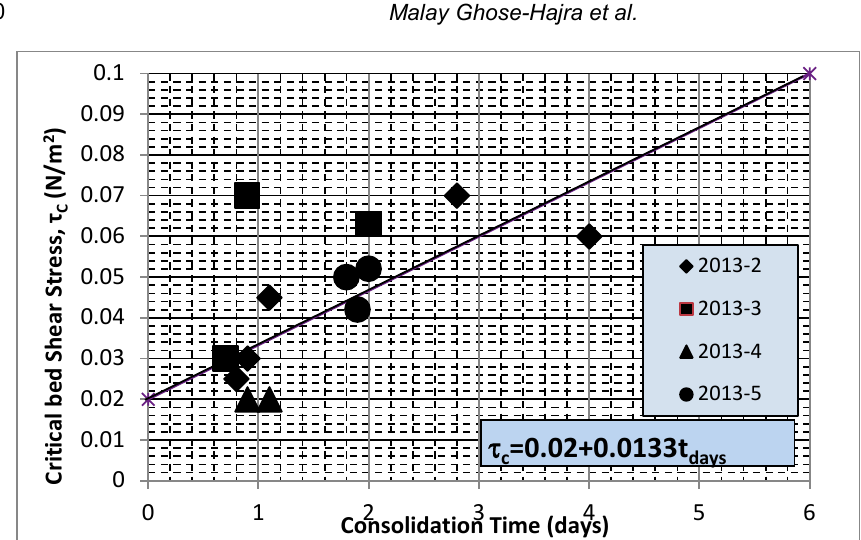
Fig. 5 Variation of critical bed shear stress with consolidation time.